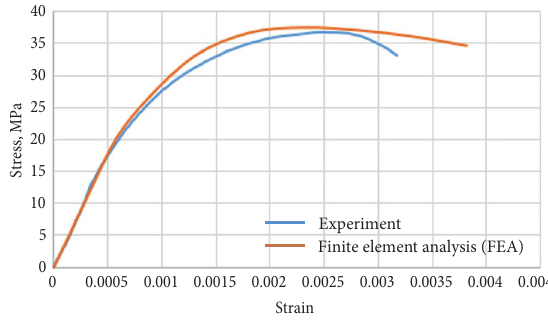
Fig. 9. Comparison of stress-strain responses of current study and experiment (Kupfer, Gerstle 1973) in uniaxial compression test